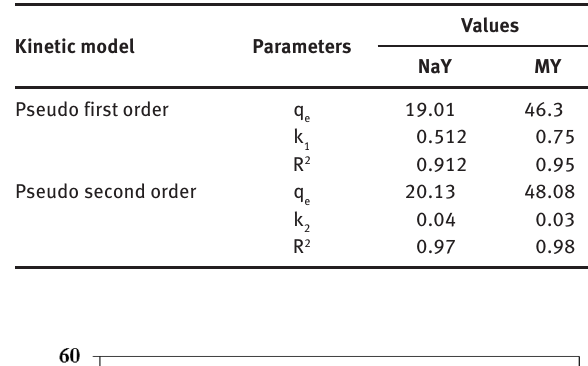
Table 5: Pseudo-first-order and Pseudo-second-order parameters for the adsorption of MB on NaY and MY.